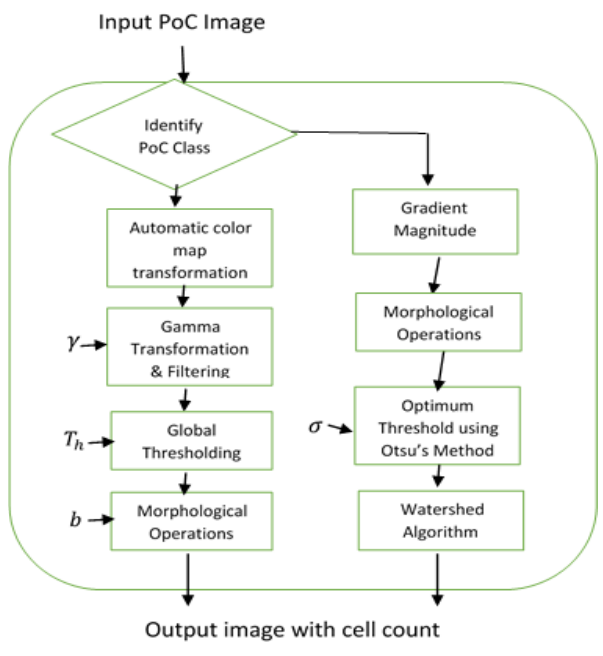
Figure 1. Flowchart summarizing the main steps of proposed algorithm for positive control images processing